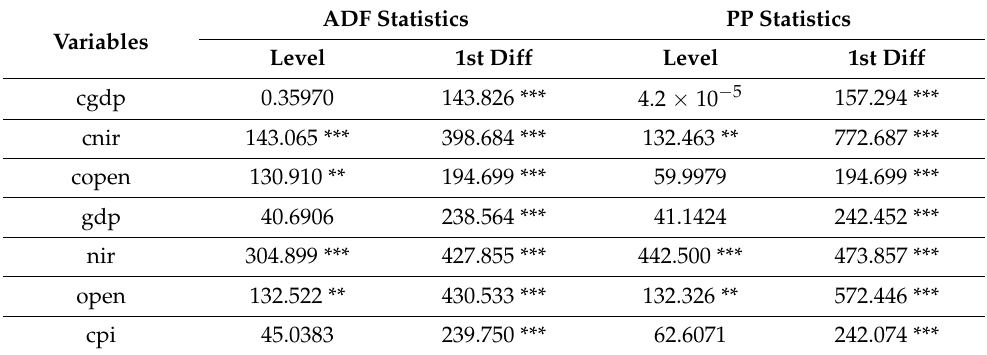
Table 3. Panel Unit Root for Chinese